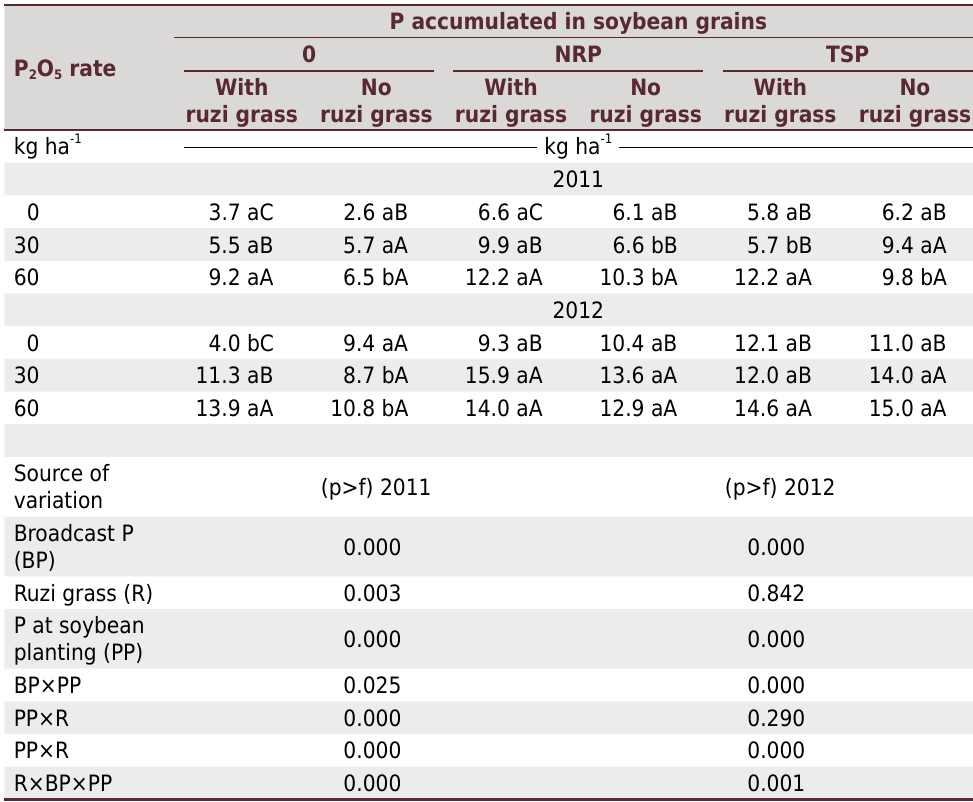
Table 5. Phosphorus accumulation in soybean grains and P values (p>f) as affected by phosphate fertilizers (soluble and reactive) broadcast in the presence and absence of ruzi grass and P rates applied to soybean seed furrows (0, 30, and 60 kg ha -1 of P 2 O 5 in the form of TSP).